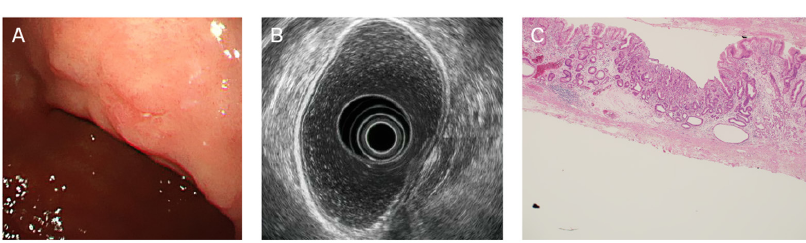
Figure 1. Endoscopic and pathologic figure of mucosal cancer. (A) The lesion was observed with white-light endoscopy; (B) EUS reveals a hypoechoic tumor regarded as the mucosal layer; (C) the histological examination after endoscopic resection demonstrated that the tumor